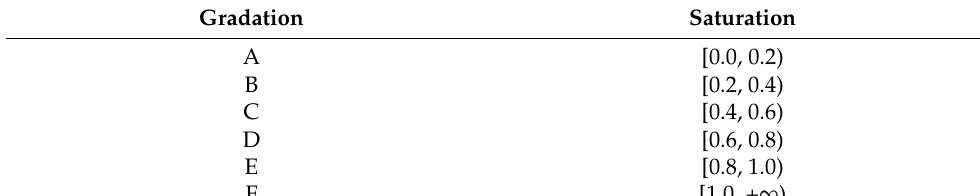
Table 1. Corresponding table of saturation and gradation.